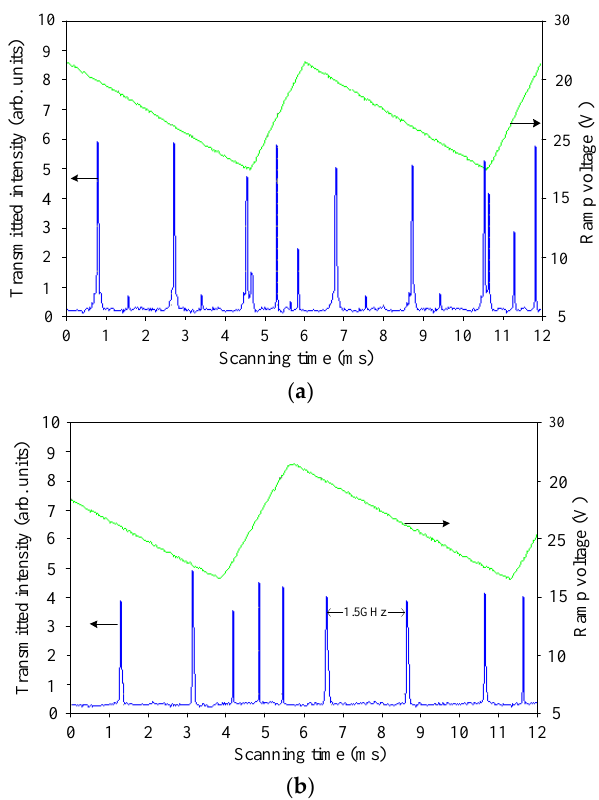
Figure 4. F-P spectrum of the signal from the MgO:PPLN OPO: ( a ) cavity without etalon; ( b ) cavity with an uncoated yttrium aluminium garnet (YAG) etalon.